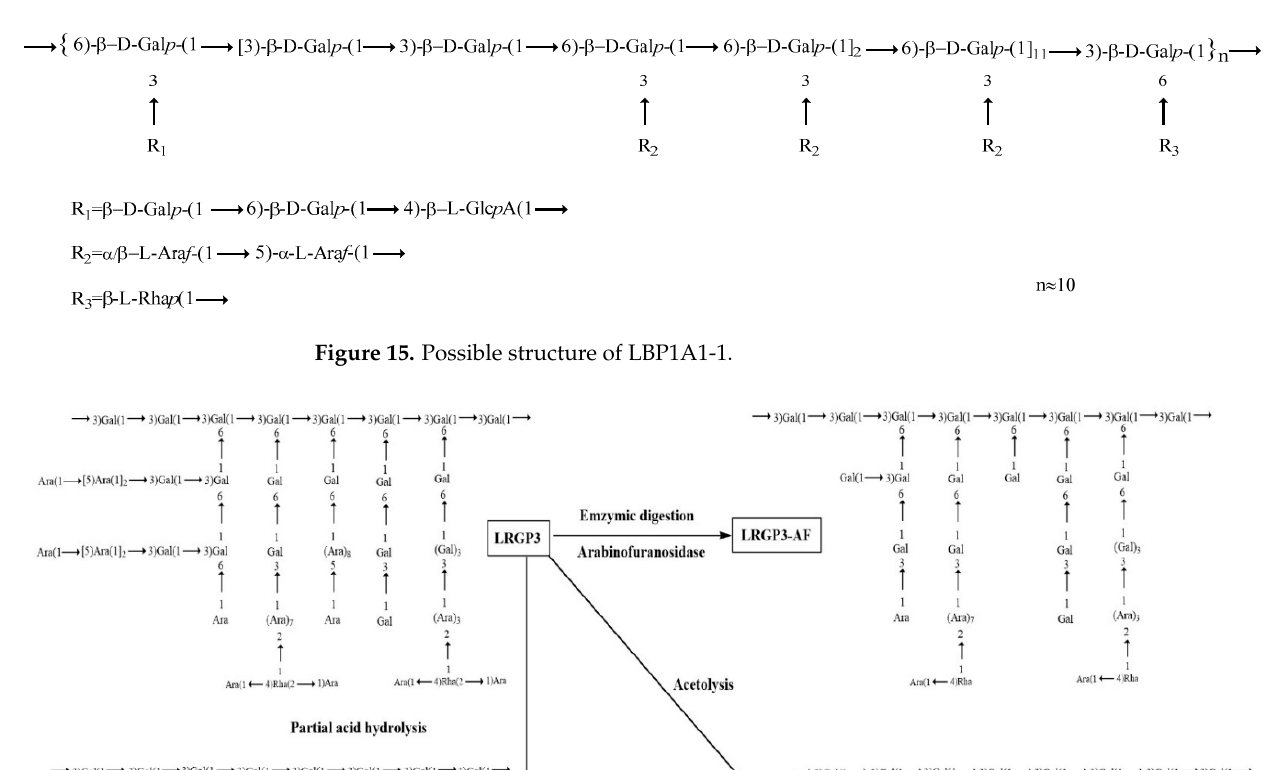
Figure 14. The chemical structure of LBPA.